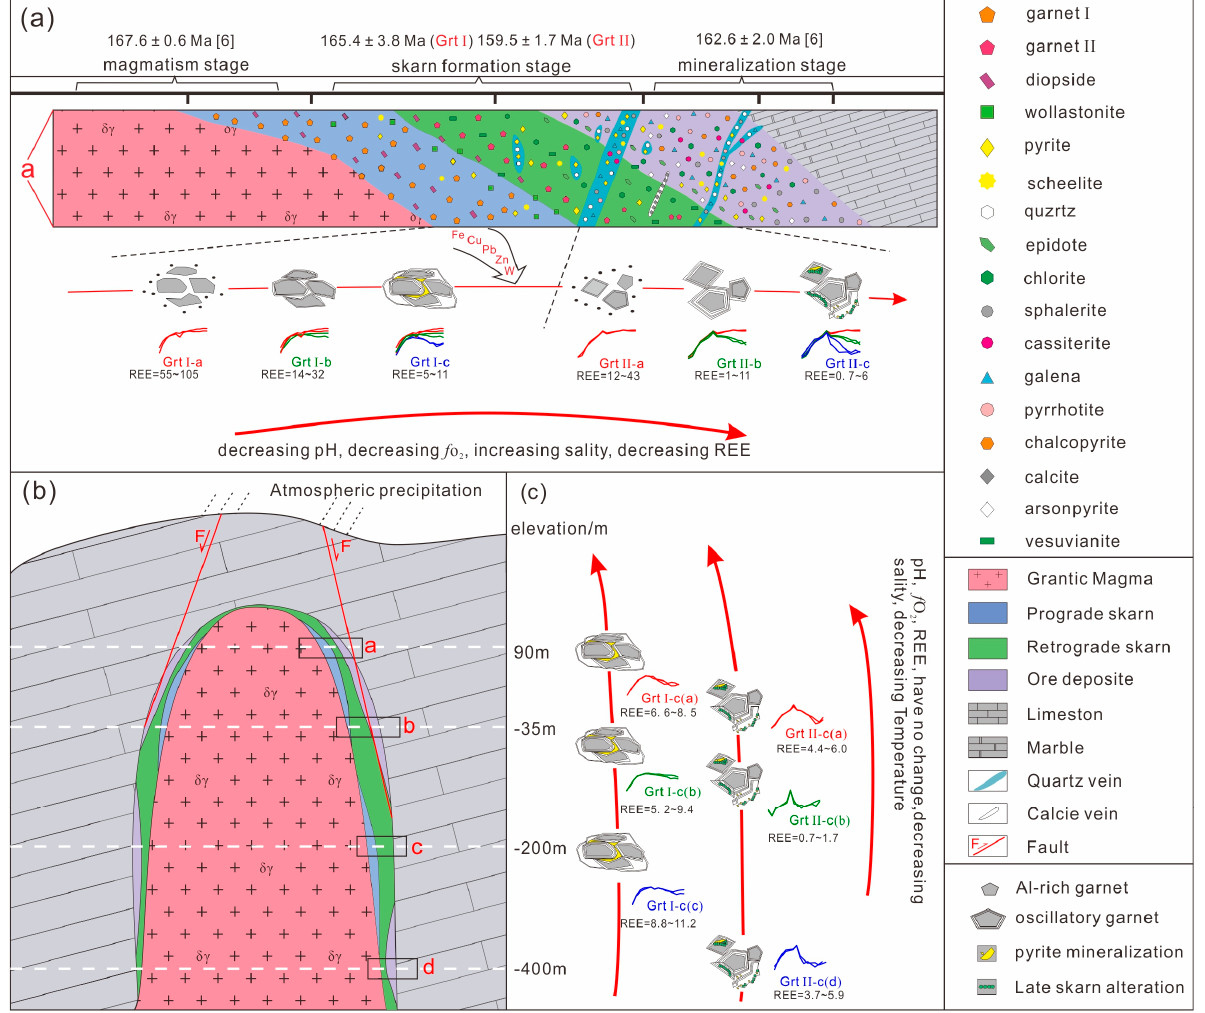
Figure 15. Spatial-temporal distribution evolution model of different types of garnets in the Tongshanling deposit. ( a ) Schematic diagram showing the horizontal textural and formation condition evolution of the Tongshanling garnet; ( b ) Schematic diagram showing horizontal and vertical zoning of skarn in Tongshanling deposit; ( c ) Schematic diagram showing the horizontal textural and formation condition evolution of the Tongshanling garnet.